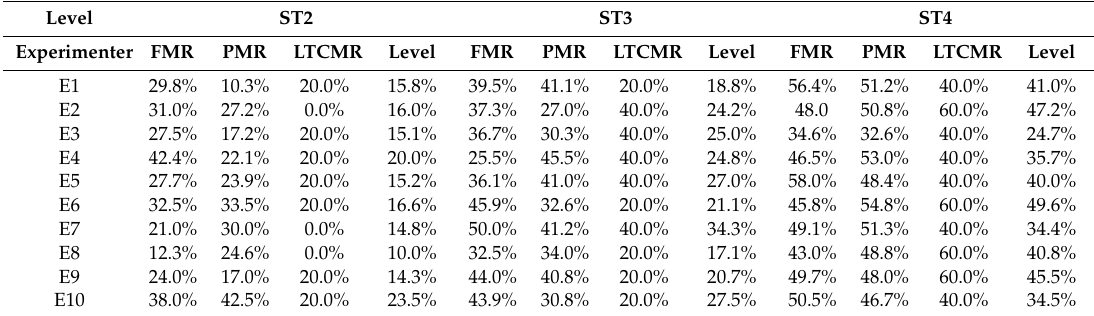
Table 8. ST2–ST4 Simulations